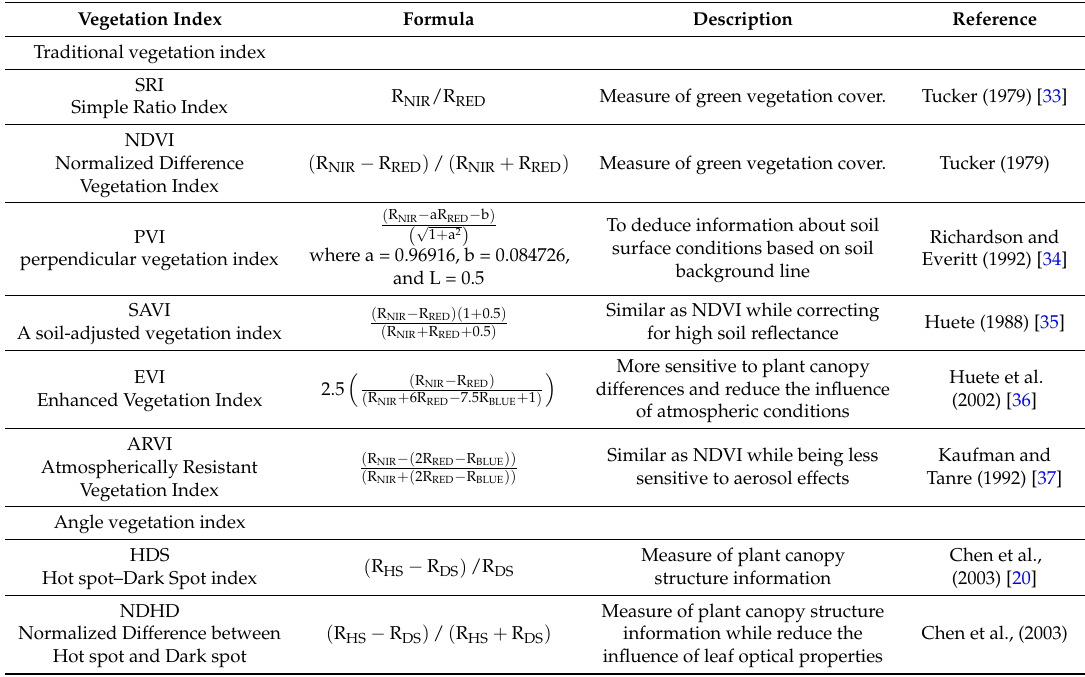
Table 4. Eight Hyperion-derived vegetation indices used in the